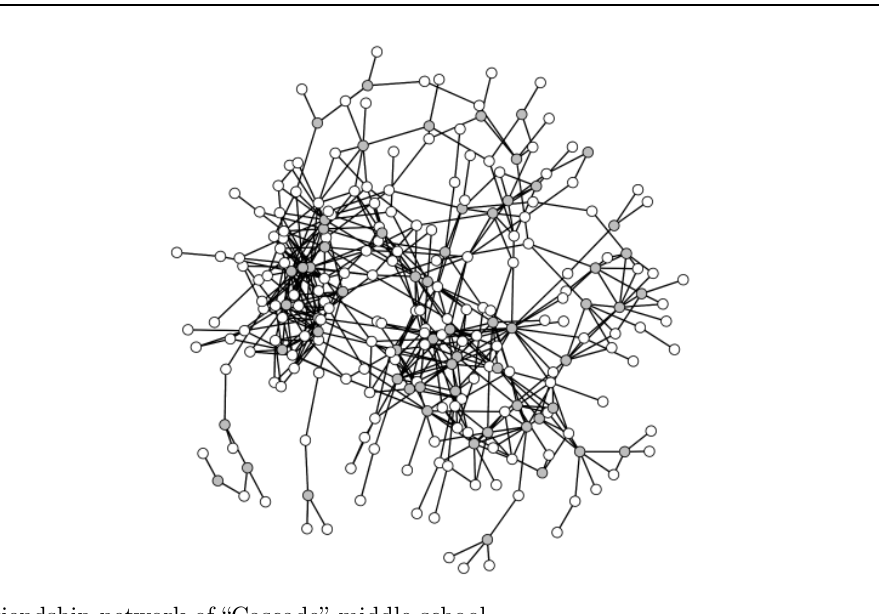
Figure 2: Friendship network of “Cascade” middle